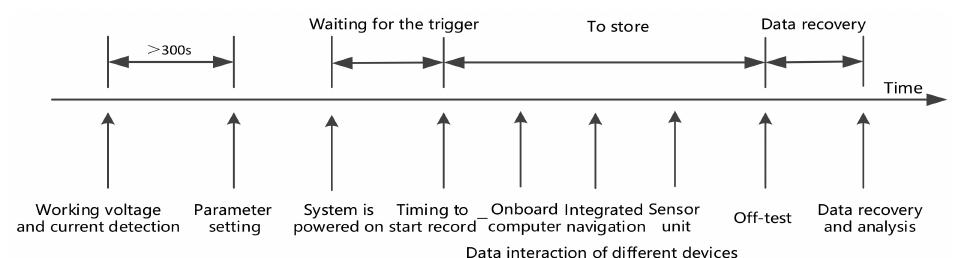
Figure 8. Working flow of the flush air data sensing module.